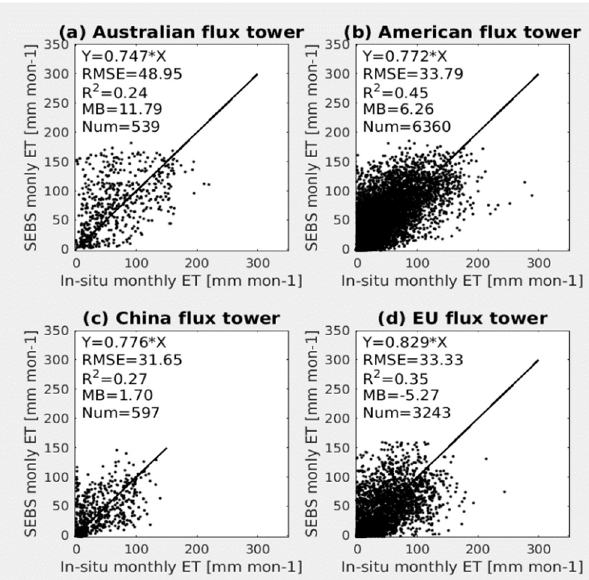
Fig. 1 Scatter density of the EB model estimates against monthly ET observation at 238 flux sites.